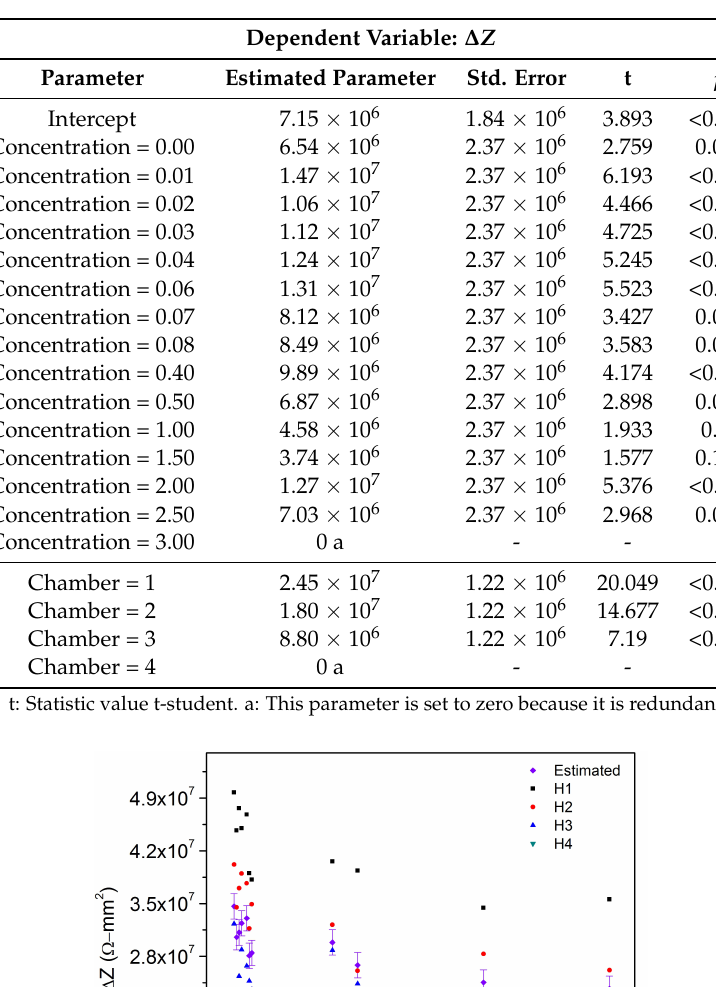
Table 9. Estimated parameters for effects model for f = 60,016 Hz.